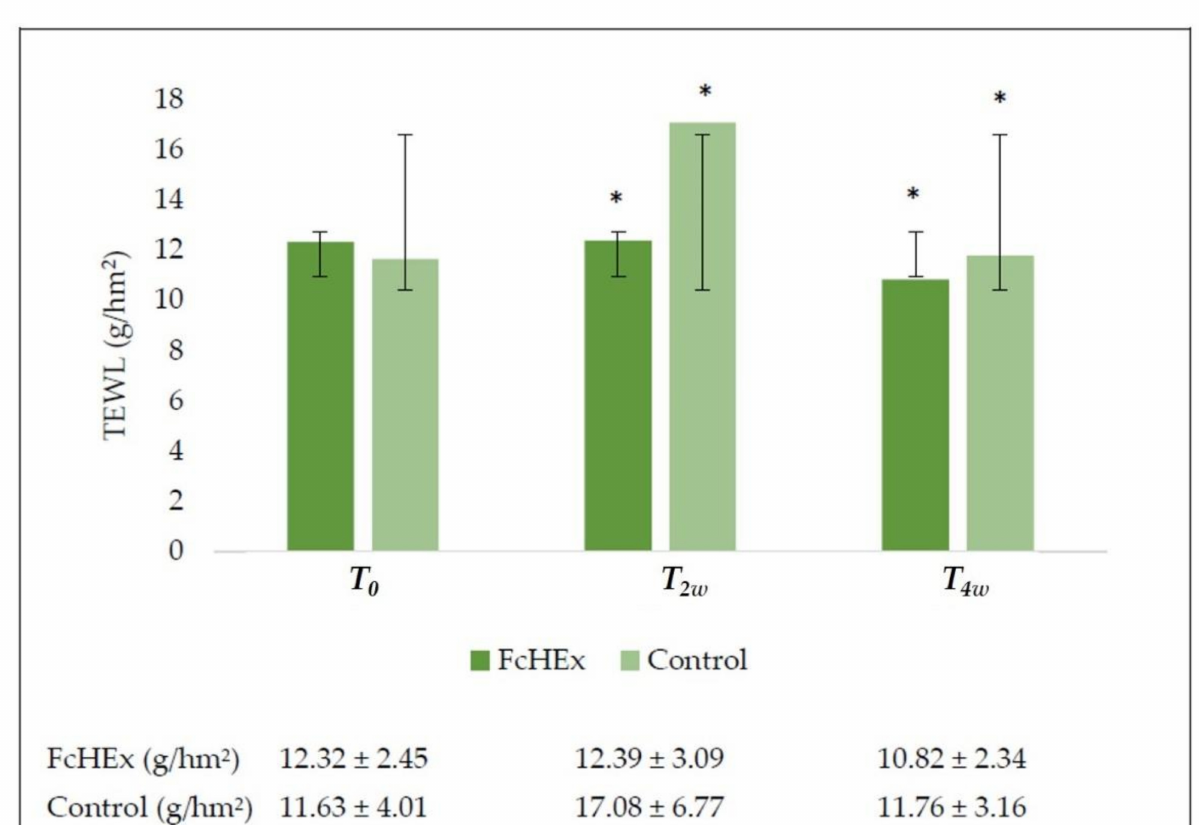
Figure 9. Transepidermal water loss evaluation (TEWL) evaluation. The TEWL trend values at time T 0 (before the application), T 2w (after two weeks—acute stress), and T 4W (after four weeks—recovery effect). All the measurements for T 2w vs. T 0 and T 4w vs. T 0 for the FcHEx and the control were statistically significant. The asterisks indicate statistically significant values (* p -value was between 0.01 and